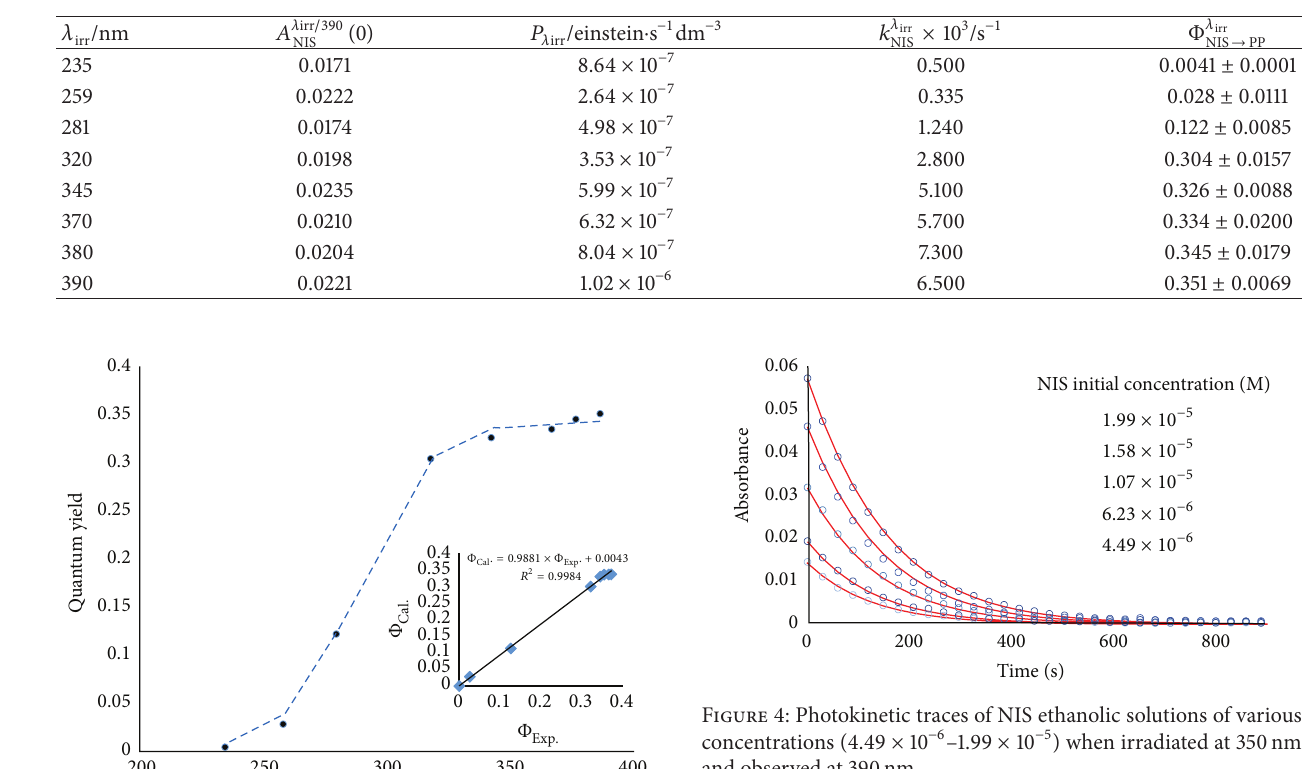
Table 1: Quantum yields and reaction parameter values for the photodegradation of NIS under different monochromatic irradiation wavelengths.